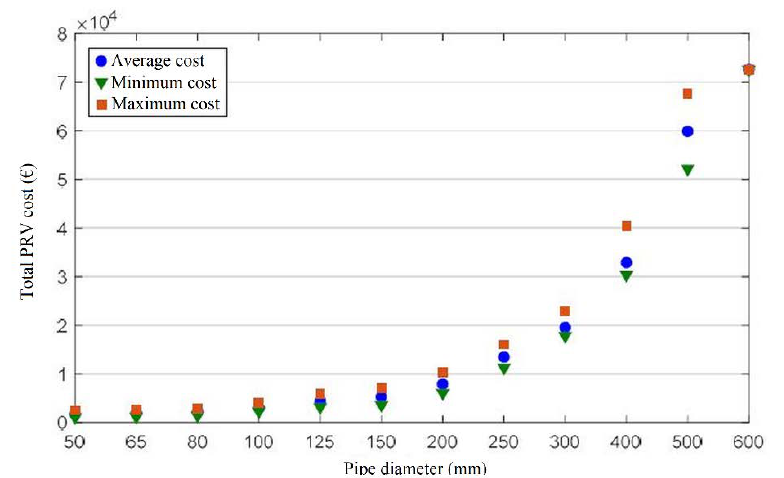
Figure 12. Total PRV cost depending on pipe diameter according to Garcia et al. (2019) [49].